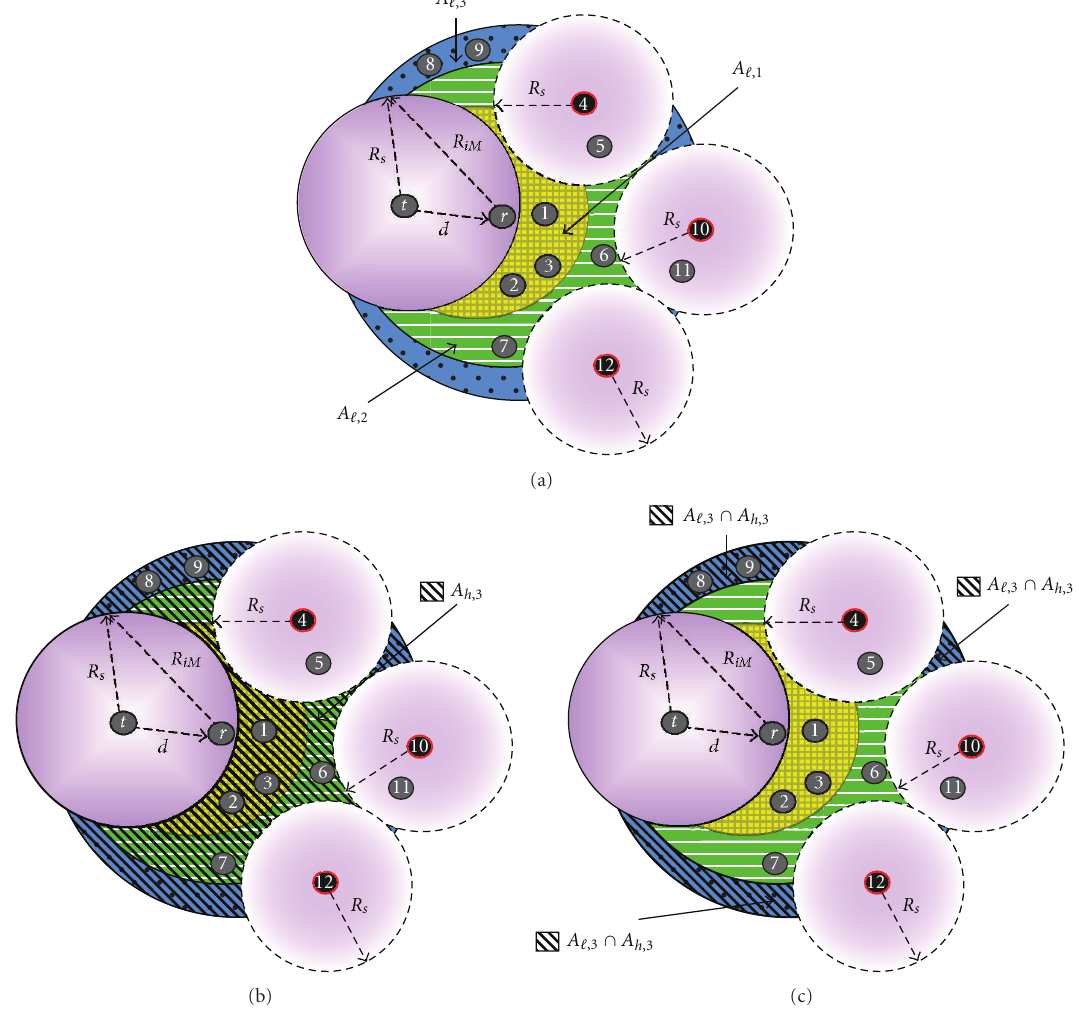
Figure 2: Illustrative example for calculating i N , r N , and P s